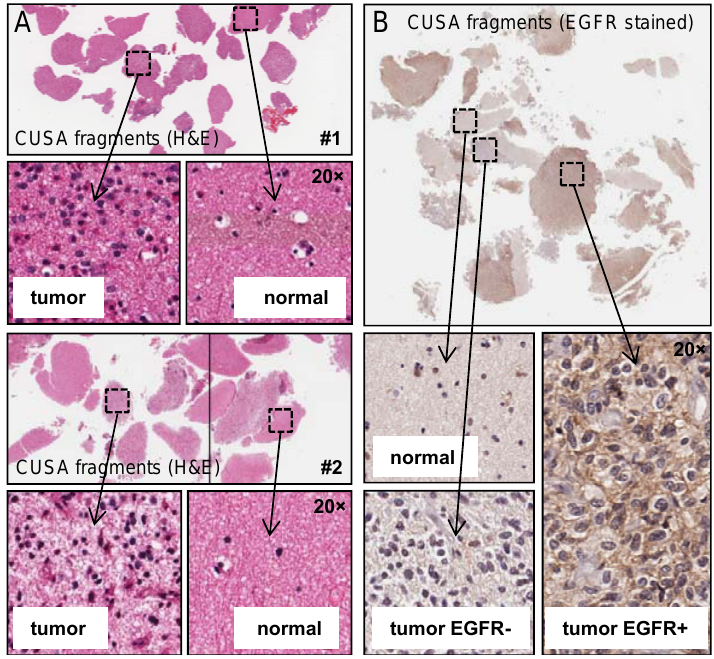
Figure 2. Intratumoral heterogeneity can be detected by IHC in CUSA surgical aspirate. ( a ) H&E sections were prepared from HGG specimens resected using the CUSA, both tumor and normal tissue were identified histologically (data for two specimens are shown); ( b ) IHC staining for a HGG-specific marker (EGFR) of CUSA tissue fragments showing intratumoral heterogeneity, tumor sections stained both positive and negative for EGFR, while normal tissue was